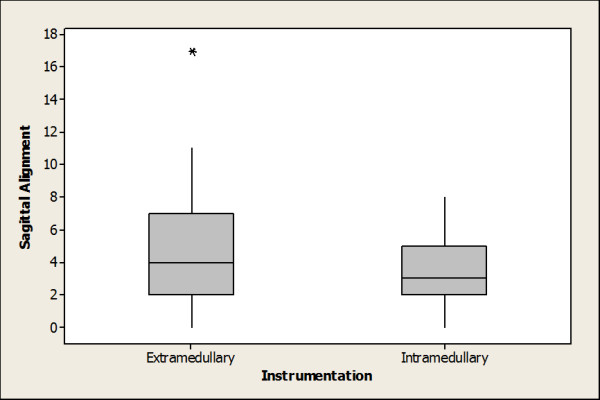
Sagittal Alignment.